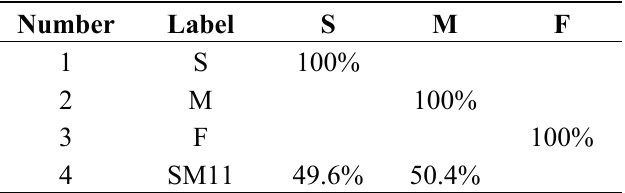
Table 3. Composition of the Red wine blends used in this